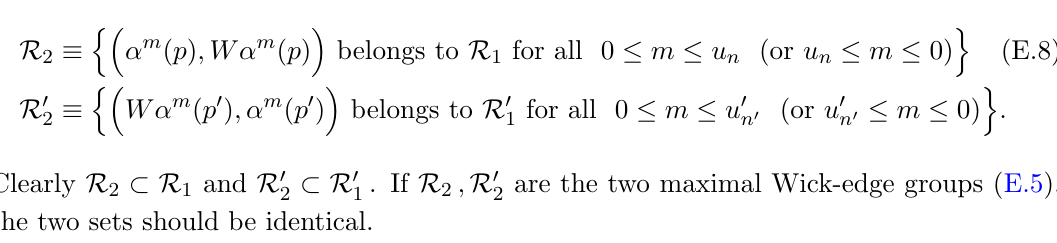
Figure 31 . (Left) Four Wick-edges adjacent to the edge ( p; p 0 ) given in (E.4). (Center) Two maximal Wick-edge groups E 1 ; E 2 . (Right) Four maximal Wick-edge groups E 1 (cid:24) E 4 . We want to (cid:12)nd the ranges ( n; n 0 ) 2 ( R 2 ; R 0 ) such 2